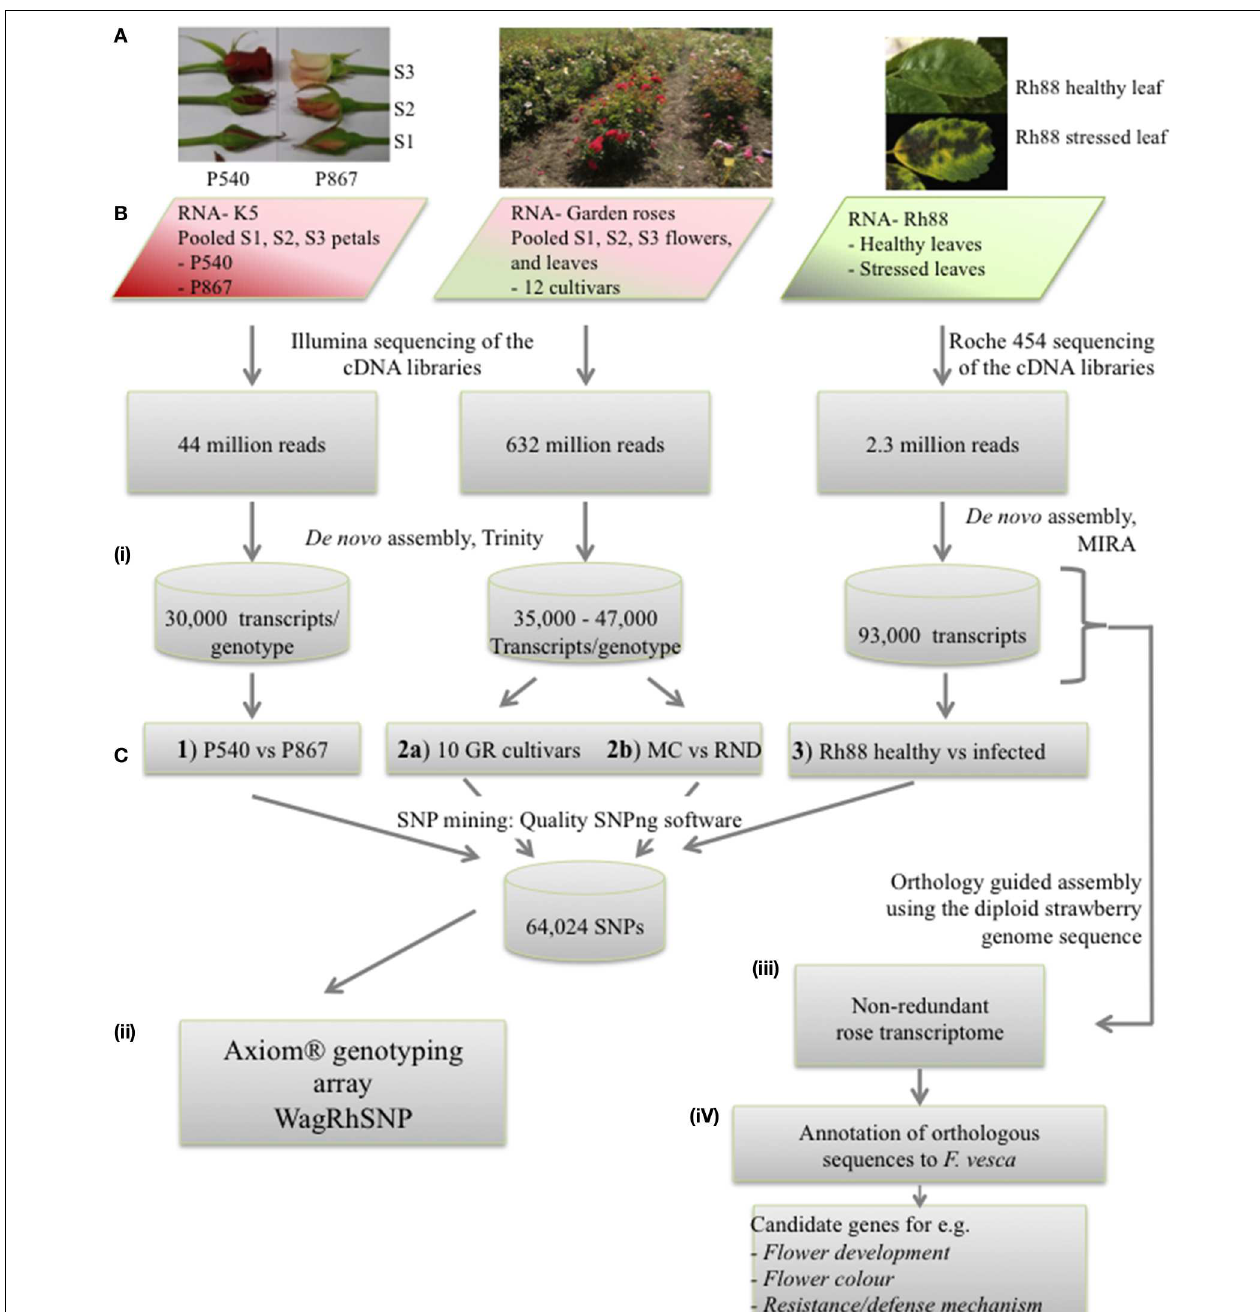
FIGURE 1 | Overview of the strategy used to assemble the rose EST data, to mine SNPs, and to develop the WagRhSNP Axion SNP array. (A) Pictures of the plant material used to isolate RNA. (B) Sequencing of the three sets. (C) Data analysis: (i) SNP mining in the three sample sets (GR, garden roses; MC, Morden Centennial; RND, Red New Dawn), (ii)